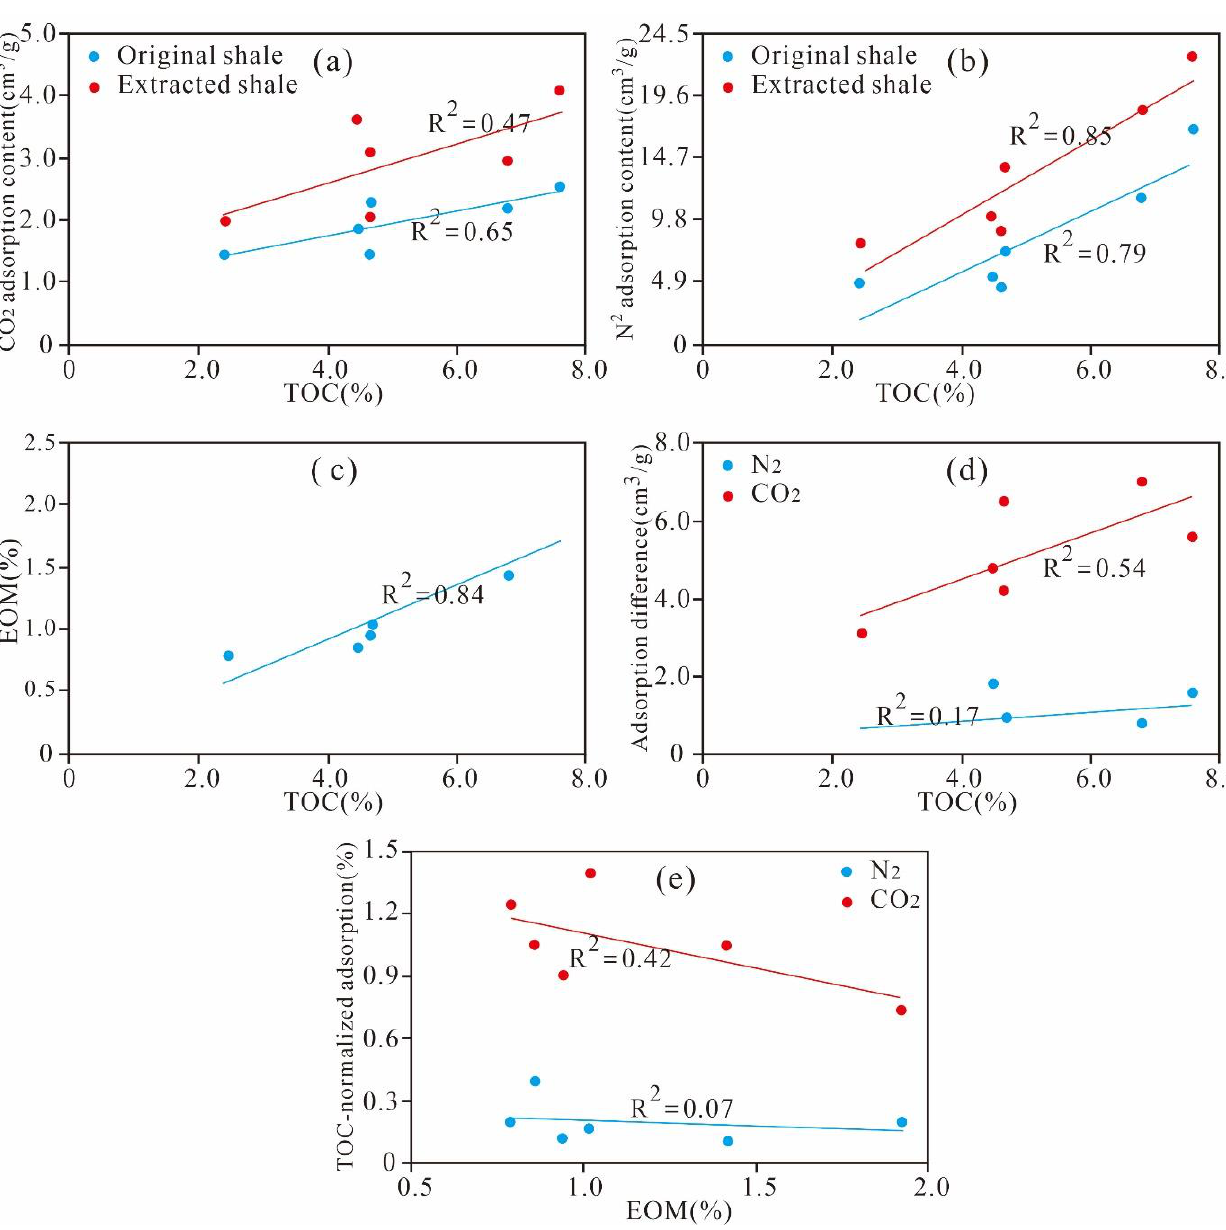
Figure 18. Correlations between gas adsorption content and ( a , b , d ) TOC content and ( c , e ) EOM. Table 4. Gap values between the micropore and mesopore PVs and SAs in the extracted samples and original shales. Sample